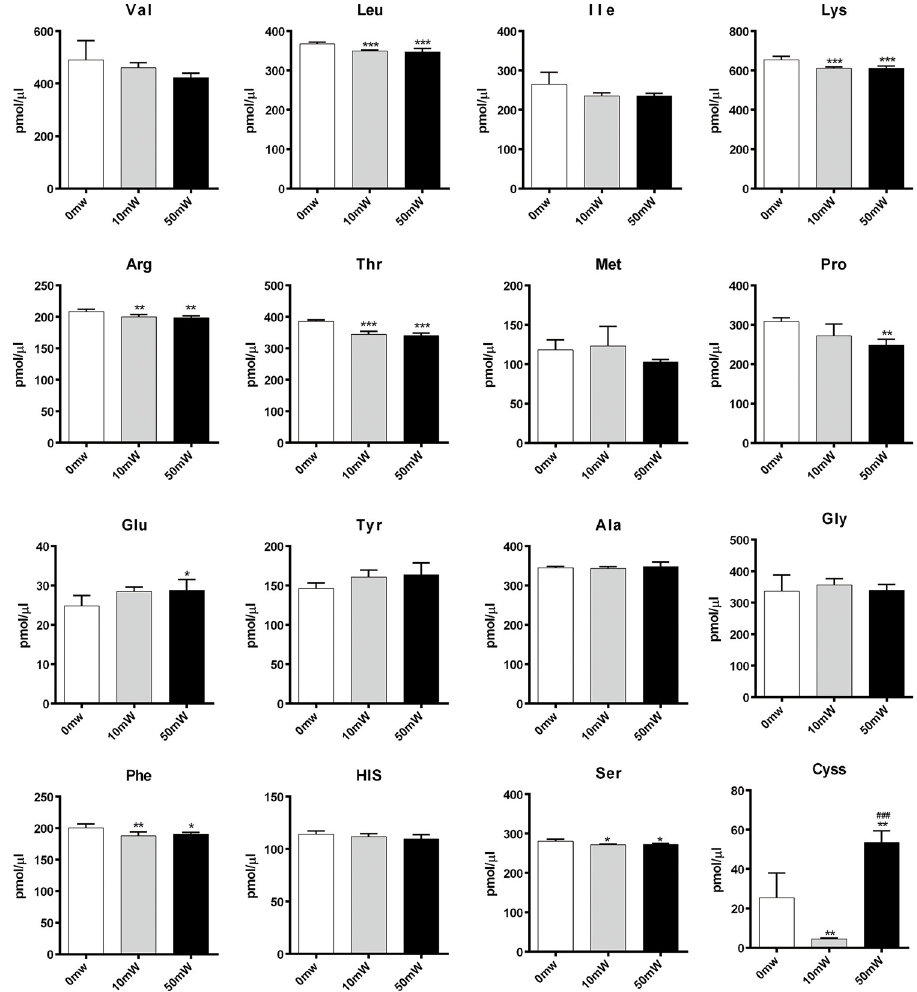
Fig 3. Effect of terahertz radiation on the release of amino acid neurotransmitters. Primary rat hippocampal neurons were radiated by terahertz wave at average power of 10 mW (0.12 THz) and 50 mW (0.157 THz) for 30 min. The culture media were collected and the concentrations of 16 amino acids were analyzed by HPLC. Sham-radiated cells were used as the controls. Data were shown as mean ± s.e.m. � p < 0.01, �� p < 0.01 and ��� p < 0.01 vs sham group; ### p < 0.01 vs 10mW